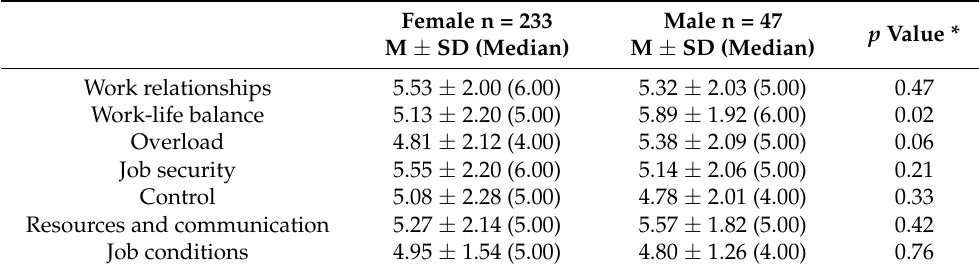
Table 5. Gender comparison regarding the level of stress.